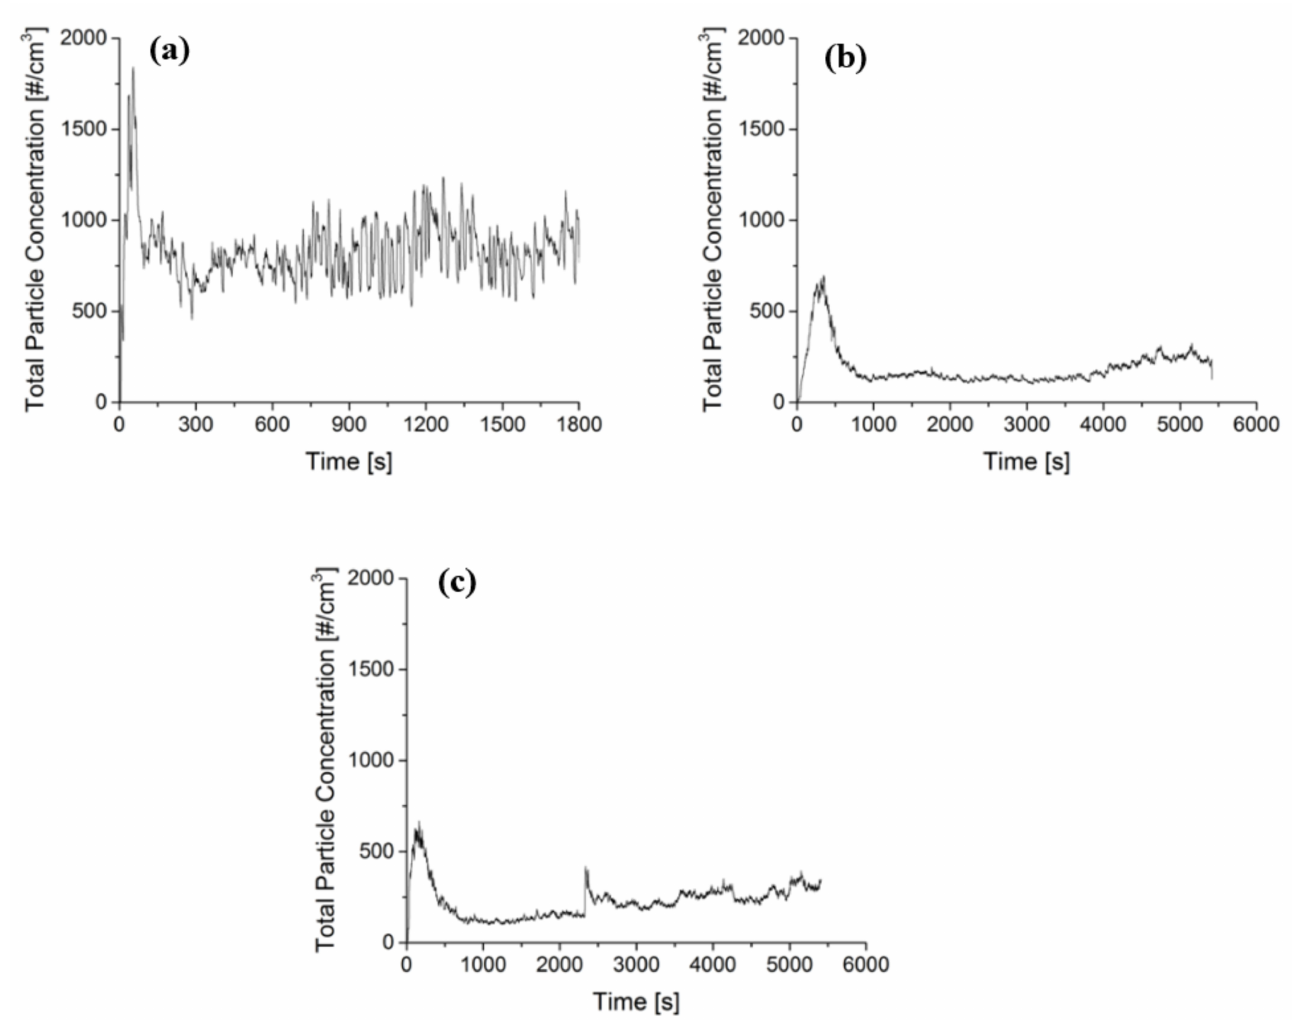
Figure 6. Emission traces that were obtained from pairings with ( a ) uncoated martensitic stainless steel; ( b ) WC-CoCr coating; and ( c ) WC-FeCrAlY